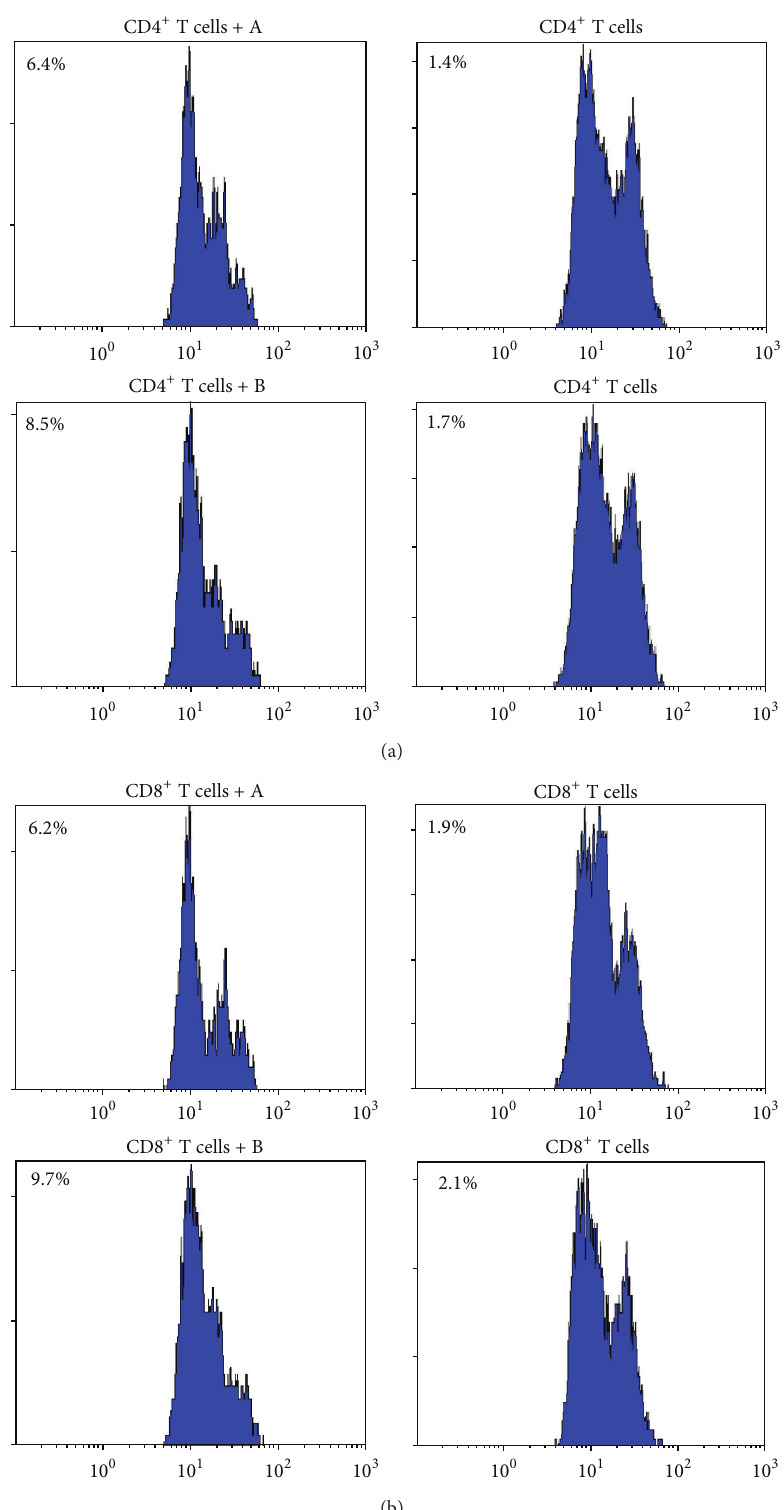
Figure 3: FCM analysis of suppressive Treg cells in vitro; (a) the suppression for CD4 + T cells by FCM analysis; (b) the suppression for CD8 +